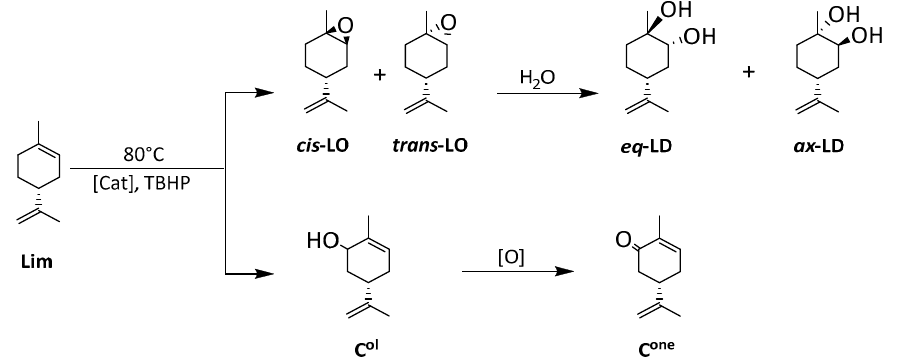
Figure 7. Comparison of conversion of CH between ( a ) H 3 PW 12 O 40 ( □ ) and SiO 2 @PW ( ), ( b ) H 3 PMo 12 O 40 ( □ ) and SiO 2 @PMo ( ). Evolution of CHO ( ), CHD ( ), CHol ( □ ) and CHone ( ● ) with ( c ) H 3 PW 12 O 40 , ( d ) H 3 PMo 12 O 40 , ( e ) SiO 2 @PW (Run 1) and ( f ) SiO 2 @PMo (Run 1).